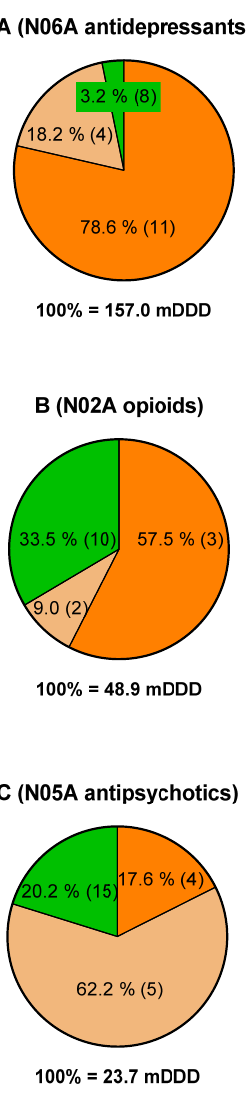
Figure 1. Percentage of total consumption in DDD in 2017 of drugs having actionable guidelines (orange), non-actionable guidelines (light brown), and no guideline (green) related to CYP2D6 and / or CYP2C19 for antidepressants ( A ), opioids ( B ), and antipsychotics ( C ). Numbers in brackets refer to the number of drugs in each category. Table 4. Consumption of drug combinations having Clinical Pharmacogenetics Implementation